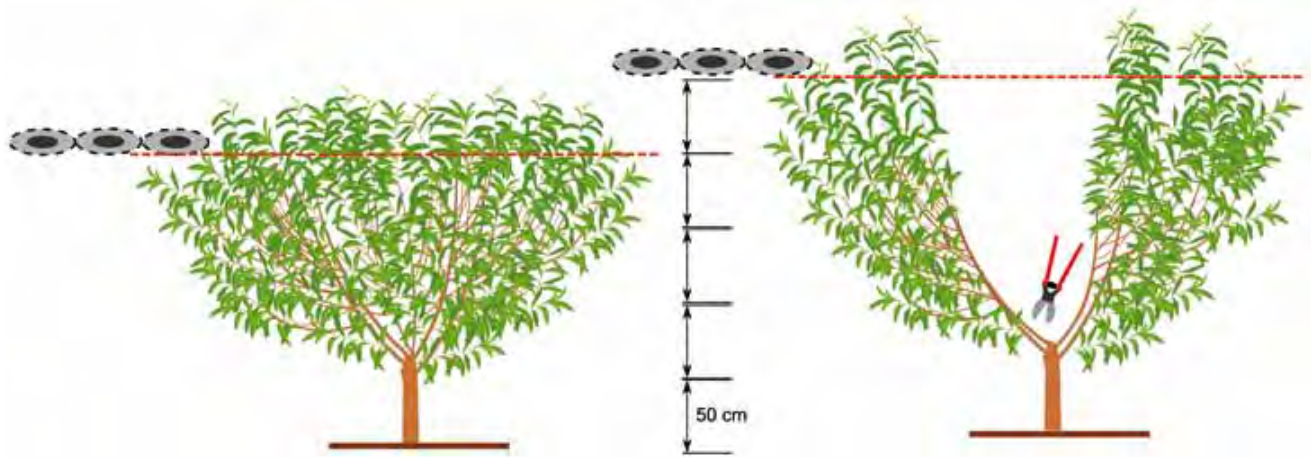
Fig. 7 - Catalonian vase during the second growing season. Left: first mechanical topping when the shoots exceed 200 cm from the soil. Right: second mechanical topping when the shoots exceed 250 cm from the soil, and manual pruning to thin the main branches down to four to five in number, opening the centre in very late summer. This last pruning is done only if the variety has a very high productivity (redrawn from Monserrat and Iglesias, 2011).